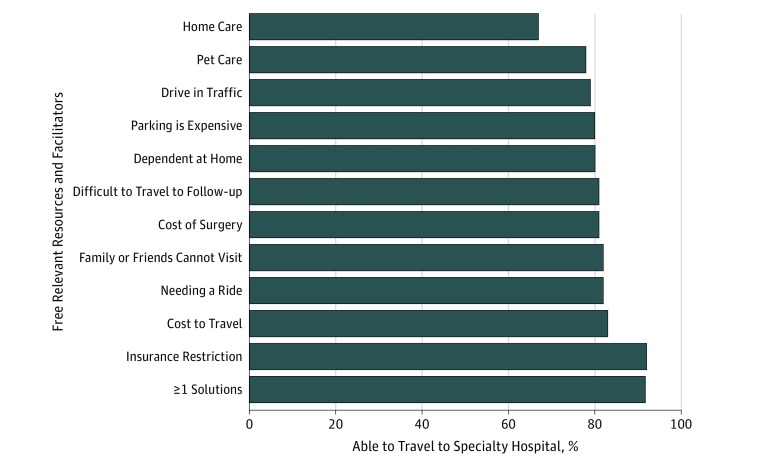
Impact of Facilitators on Respondents With Related BarriersThe percentage of restricted respondents who could travel to the specialty hospital if allocated the relevant resource or facilitator for free.